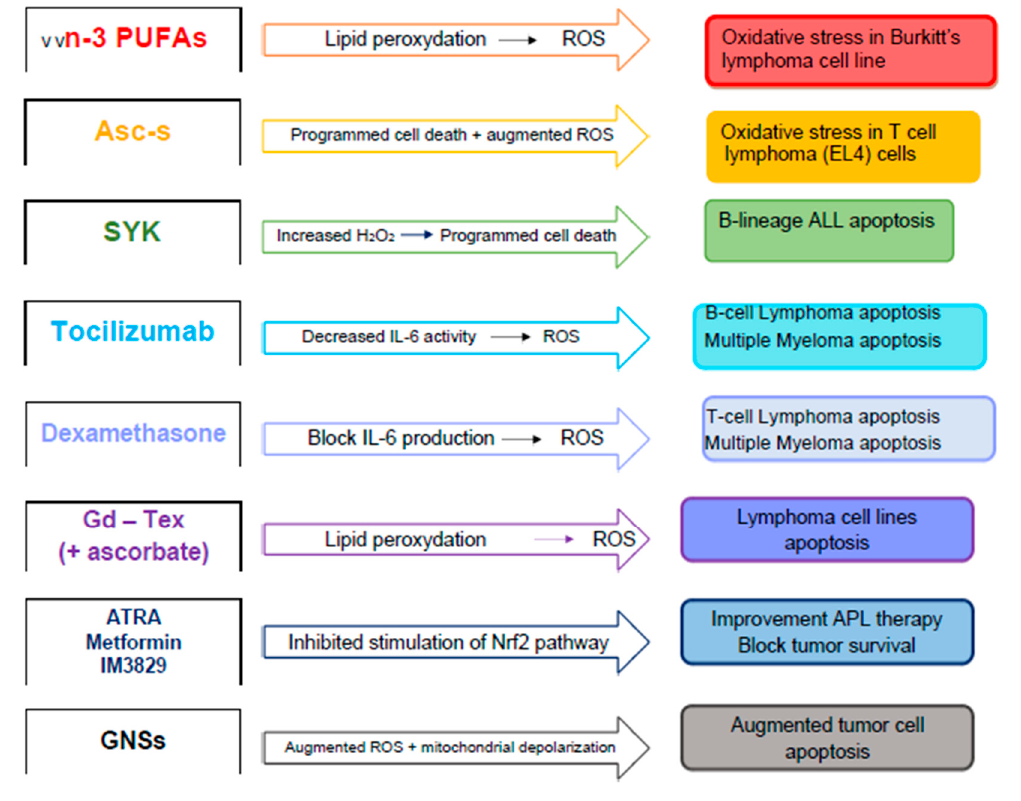
Figure 2. Reactive oxygen species (ROS)-sensitive molecular pathways implicated in survival signaling.